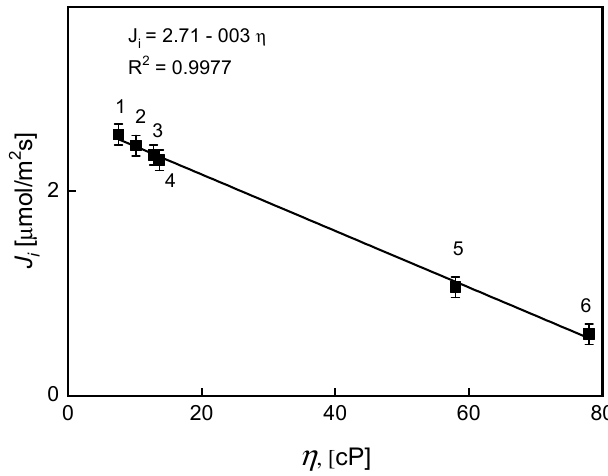
Figure 6. The effect of plasticizer viscosity on the initial fluxes of Ag(I) transport across PIMs. Source phase: 1.0 × 10 − 3 M AgNO 3 (pH = 4,0); PIMs: 25.0 mg CTA, 4.0 cm 3 o -NPPE (1), TOF (2), o -NPOE (3), DOA (4), TCF (5), DOP (6) / 1.0 g CTA; 0.050 M KP; receiving phase: 0.10 M Na 2 S 2 O 3 .